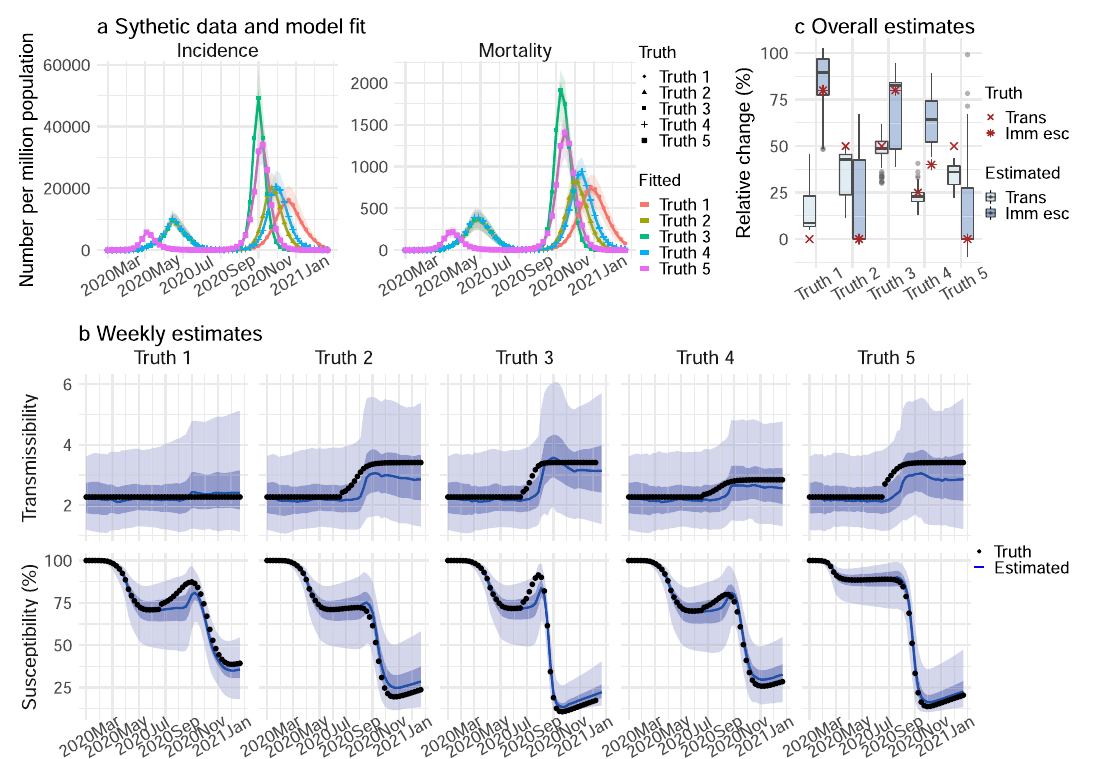
Fig. 1 Model-inference system validation using model-generated synthetic data with an infection-detection rate of 20%. For this testing, the true values of incidence and mortality by week ( a ), transmissibility by week ( b , top panel), population susceptibility by week ( b , bottom), and overall changes in transmissibility and immune escape due to a new variant ( c ) were generated by model simulations with prescribed parameters and conditions. Unlike the real world, in which most epidemiological characteristics are unobserved, here these quantities (i.e., the “ Truth ” ) are prescribed and known and thus can be compared to estimates made with the model-inference system using the synthetic, model-generated incidence and mortality data ( a ). a Five sets of synthetic data (dots) and model- fi ts to each data set; lines show mean estimates and surrounding areas show 50% (dark) and 95% (light) CrIs. b Weekly model-estimated transmissibility and population susceptibility. The lines show mean estimates and surrounding areas show 50% (dark) and 95% (light) CrIs, compared to the true values (dots). c overall estimates of the change in transmissibility (Trans) and immune escape (Imm esc), compared to the true values (dots); boxes show model-estimated median (middle bar) and interquartile range (box edges), and whiskers show model-estimated 95% CIs, from n = 100 model-inference simulations. Table 1 Estimated changes in transmissibility and level of immune evasion, compared to the wild-type virus.